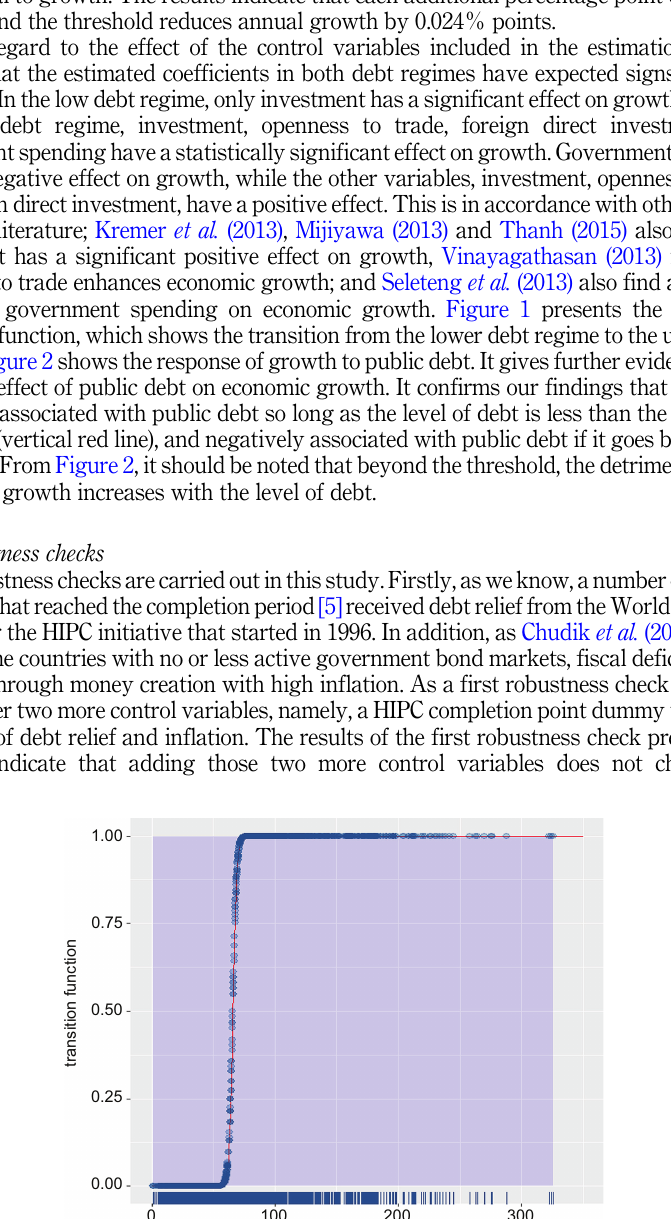
Figure 1. Estimated transition